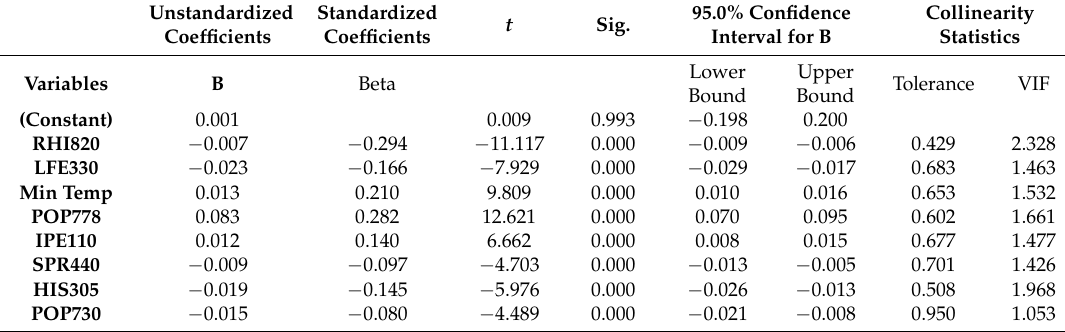
Table 4. Effects of environment and socio-economic factors on the log (STIR) using LR